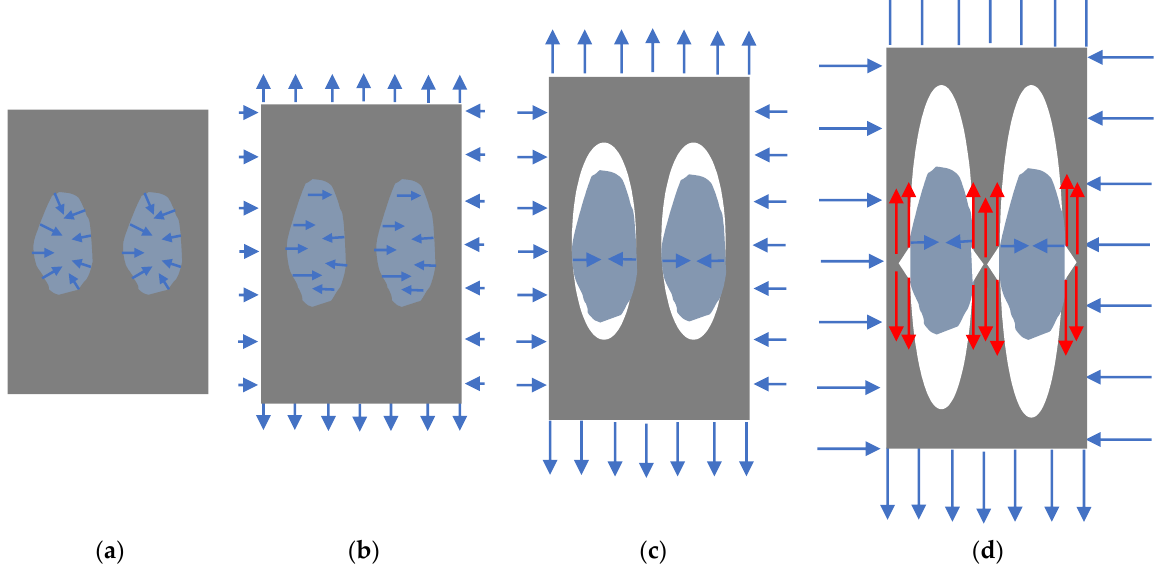
Figure 3. Schematic representation of the CaCO 3 fille HPP composites at equilibrium and under tensile load: ( a ) residual stress in CaCO 3 particles, ( b ) initial stage of elastic deformation zone, ( c ) the end point of the elastic deformation zone, and ( d ) the yielding point of the composites.